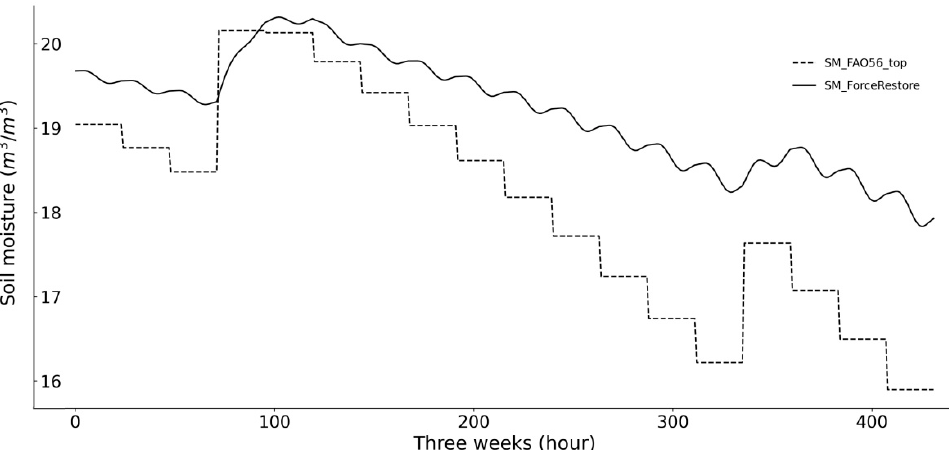
Figure 9. Example of SSM dynamic simulated by the modified FAO-56 (dashed line) and the force-restore model (dash and point line) after a wetting event.